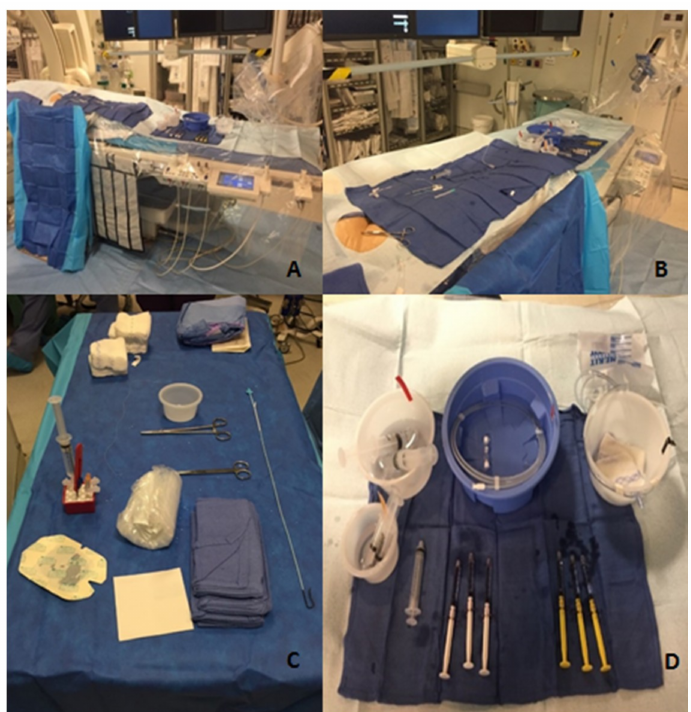
Figure 7. Room organization. (a) Patient table and control; (b) Patient table and power injector; (c) Equipment table; (d) Procedural